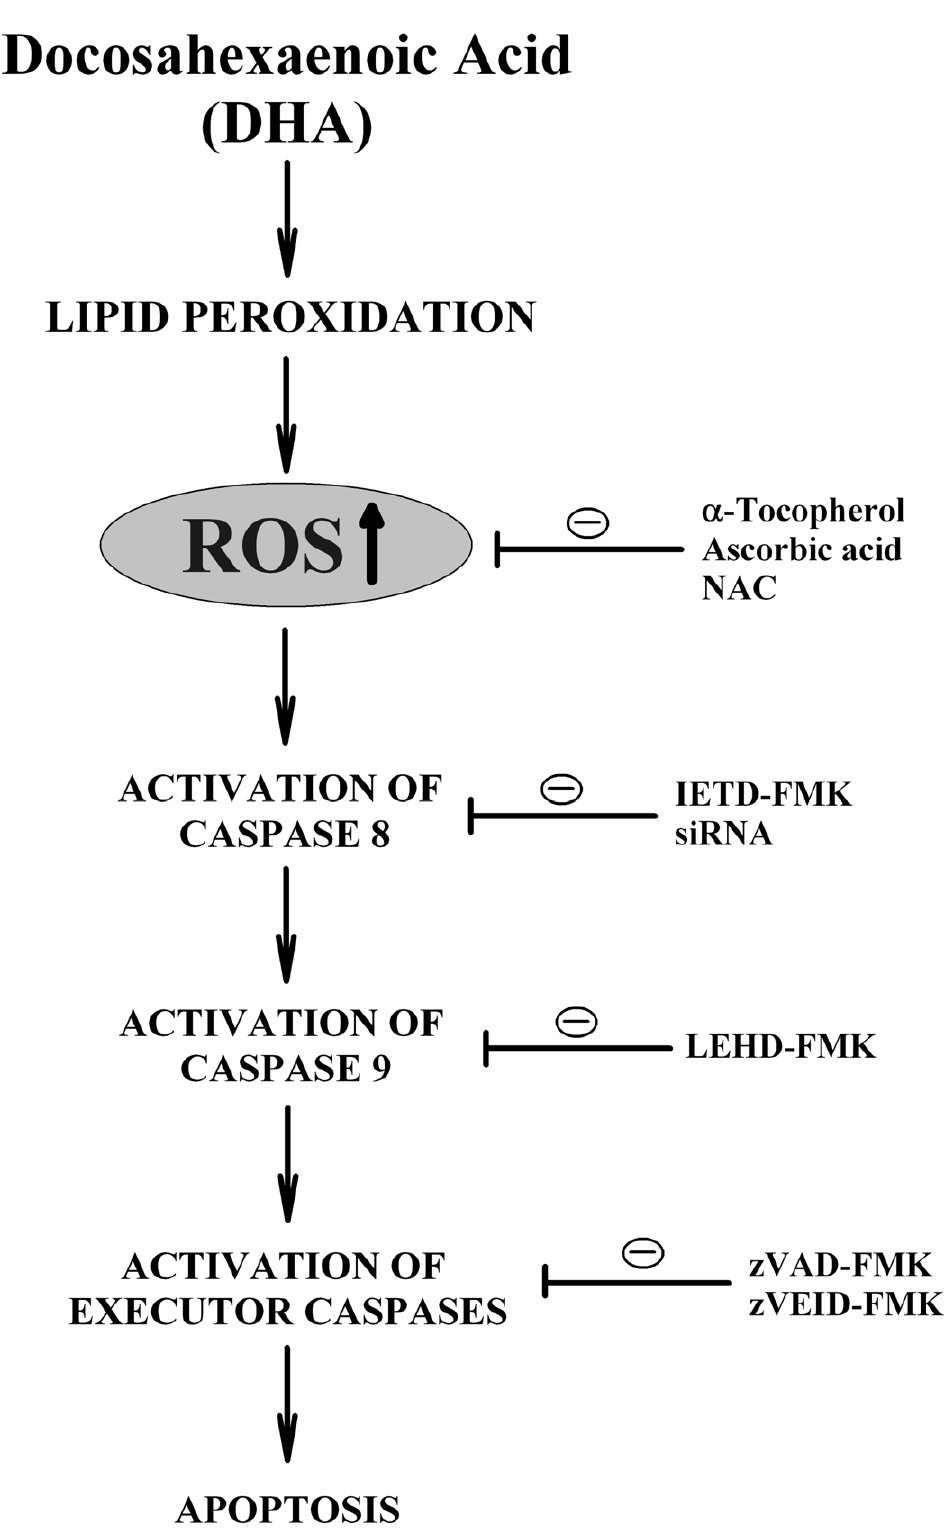
Figure 7. A scheme depicting the mechanism of DHA-induced death in MCF-7 human breast cancer cells. The presence of markedly elevated intracellular levels of DHA would increase lipid peroxidation and result in increased production of ROS. Accumulation of ROS results in the activation of caspase 8, which then activates its downstream caspase 9 as well as executor caspases. The activation of these caspases results in the induction of apoptotic cell death. When antioxidants are co-present, they can effectively protect cells from undergoing apoptosis by suppressing ROS formation. In comparison, the presence of inhibitors for various caspases or the selective knockdown of caspase 8 each shows a strong protection of cells from DHA-induced apoptosis.